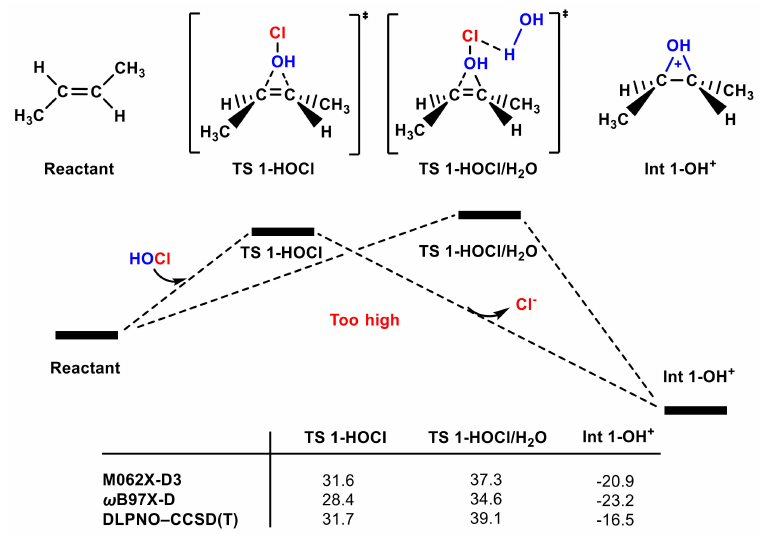
Figure 2. The partial PES of the OH group in the HOCl molecule attacking trans-1,2-dimethyl ethylene. The Gibbs free energies of TS 1-HOCl , TS 1-HOCl/H 2 O , and Int 1-OH + according to different methods are included (in kcal mol − 1